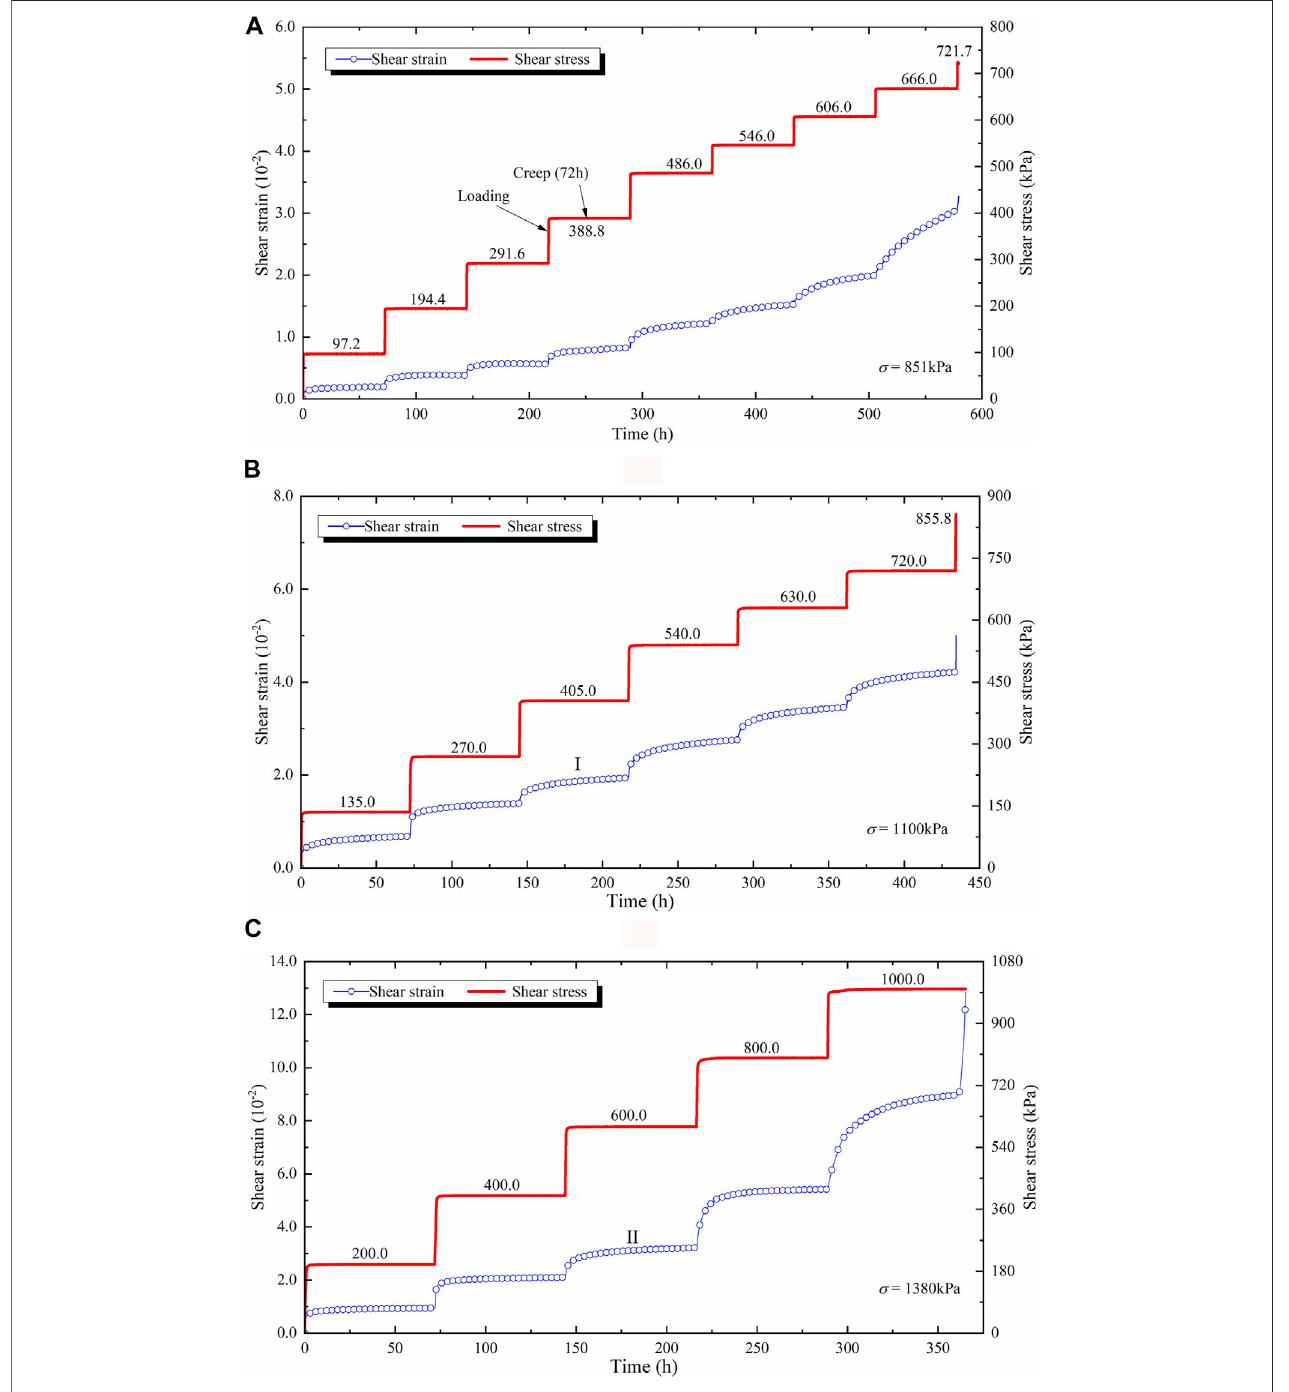
FIGURE 6 | Results of shear creep tests of undisturbed samples of the sliding zone under normal stresses of (A) 851 kPa, (B) 1,100 kPa, (C) 1,380 kPa.